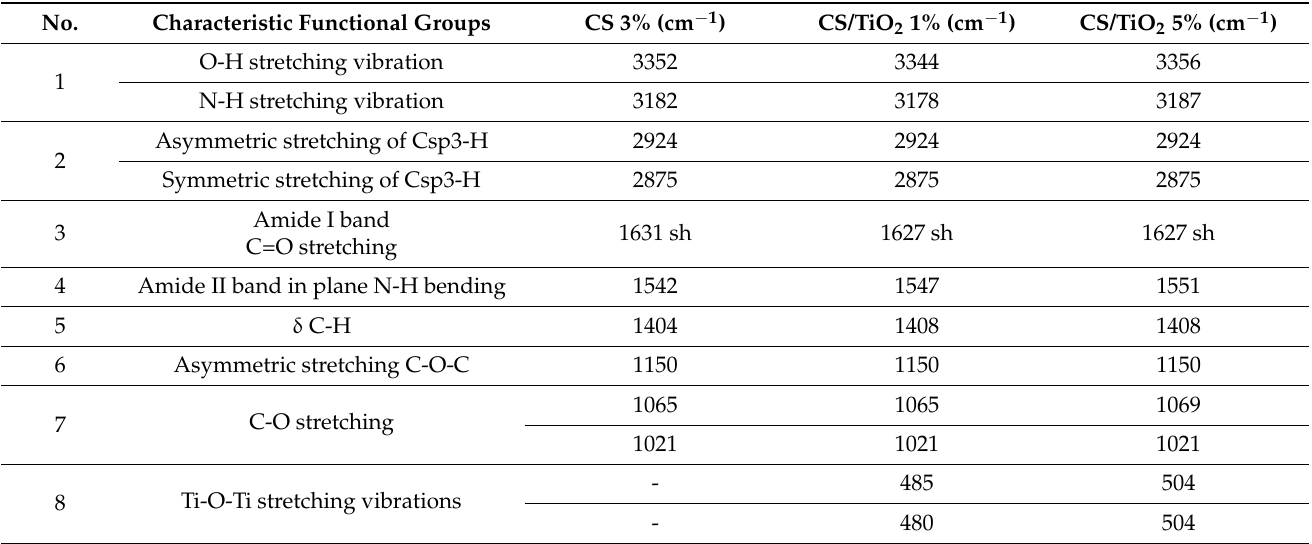
Figure 2. FTIR analysis of chitosan and chitosan/TiO 2 composite membranes. Table 1. Assignment of relevant IR absorption bands of chitosan and TiO 2.